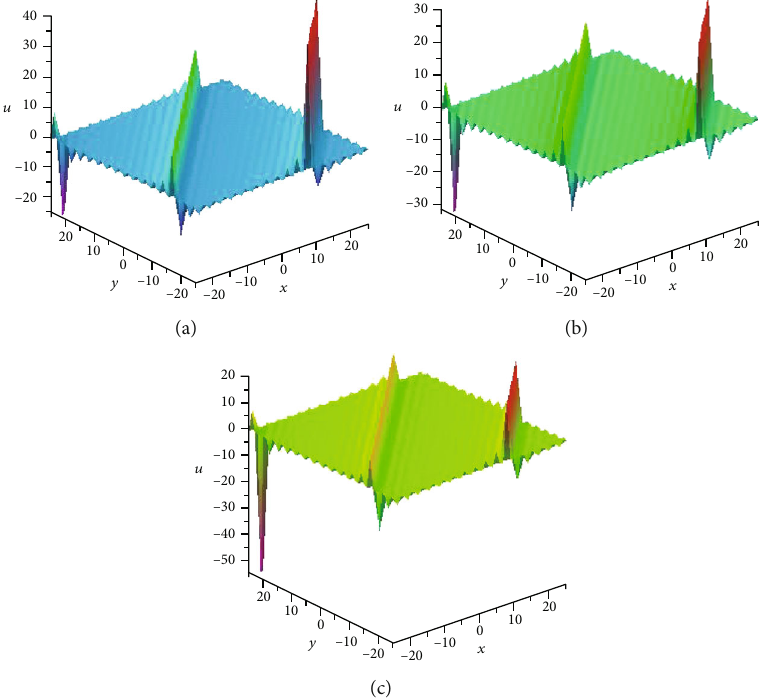
Figure 4: Evolution of Equation (64) at (a) t = 0 : 479 , (b) t = 0 : 48 , and (c) t = 0 : 4815 .